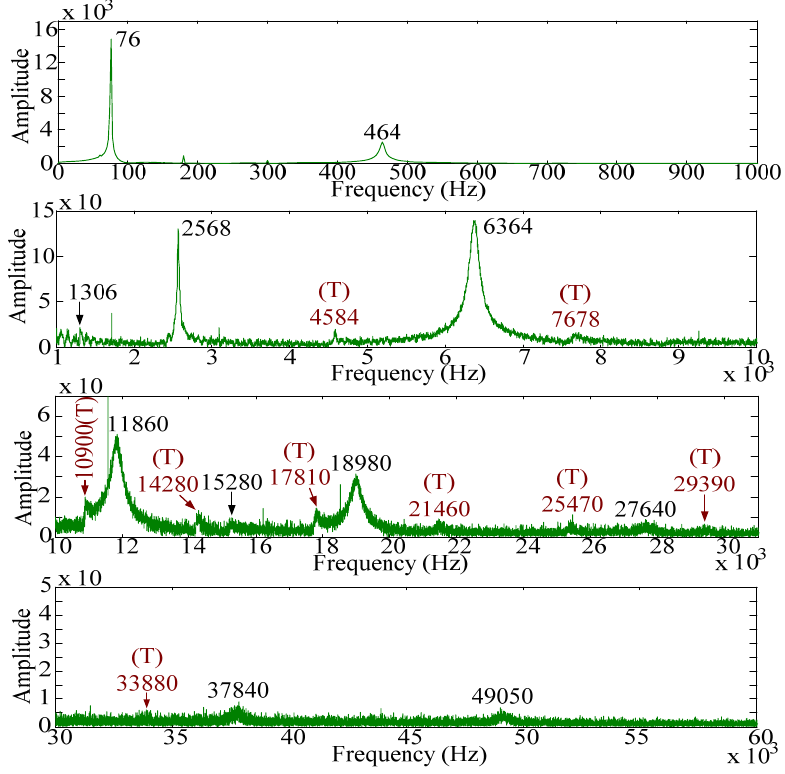
Figure 21. Frequency spectrum of PVDF 5 × 2.5 with impact on location B.